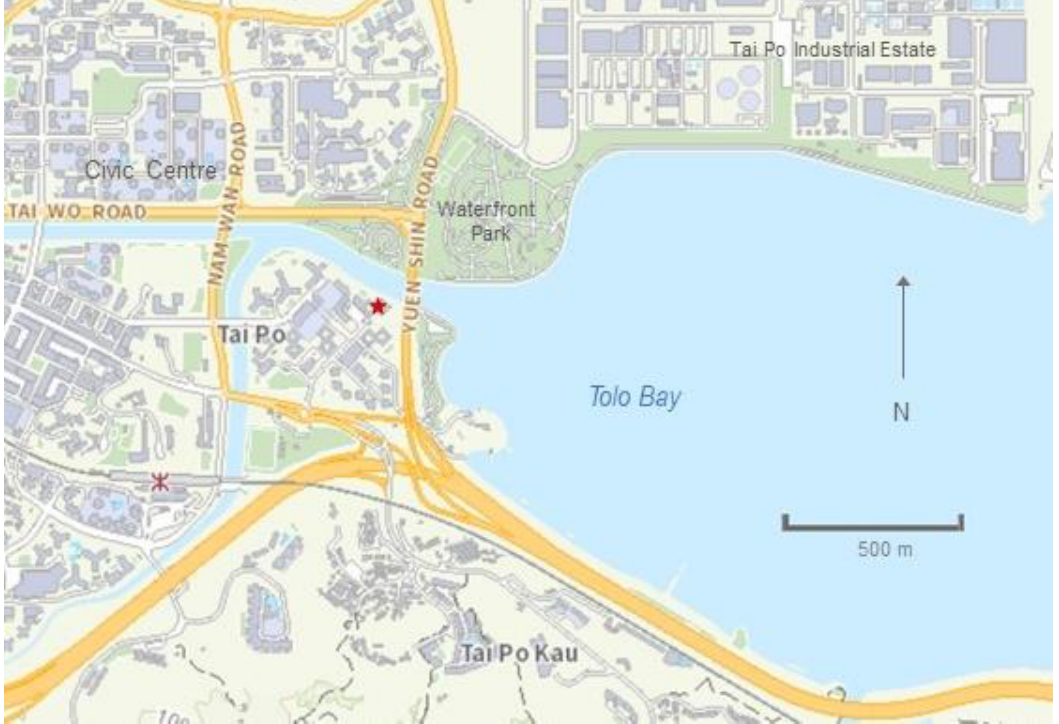
Figure 1. Map of Tai Po, Hong Kong (coastal area off Tolo Bay). (Source of basemap: Hong Kong Lands Department, GeoInfo Map https://www.map.gov.hk/gm, accessed on 1 March 2021).